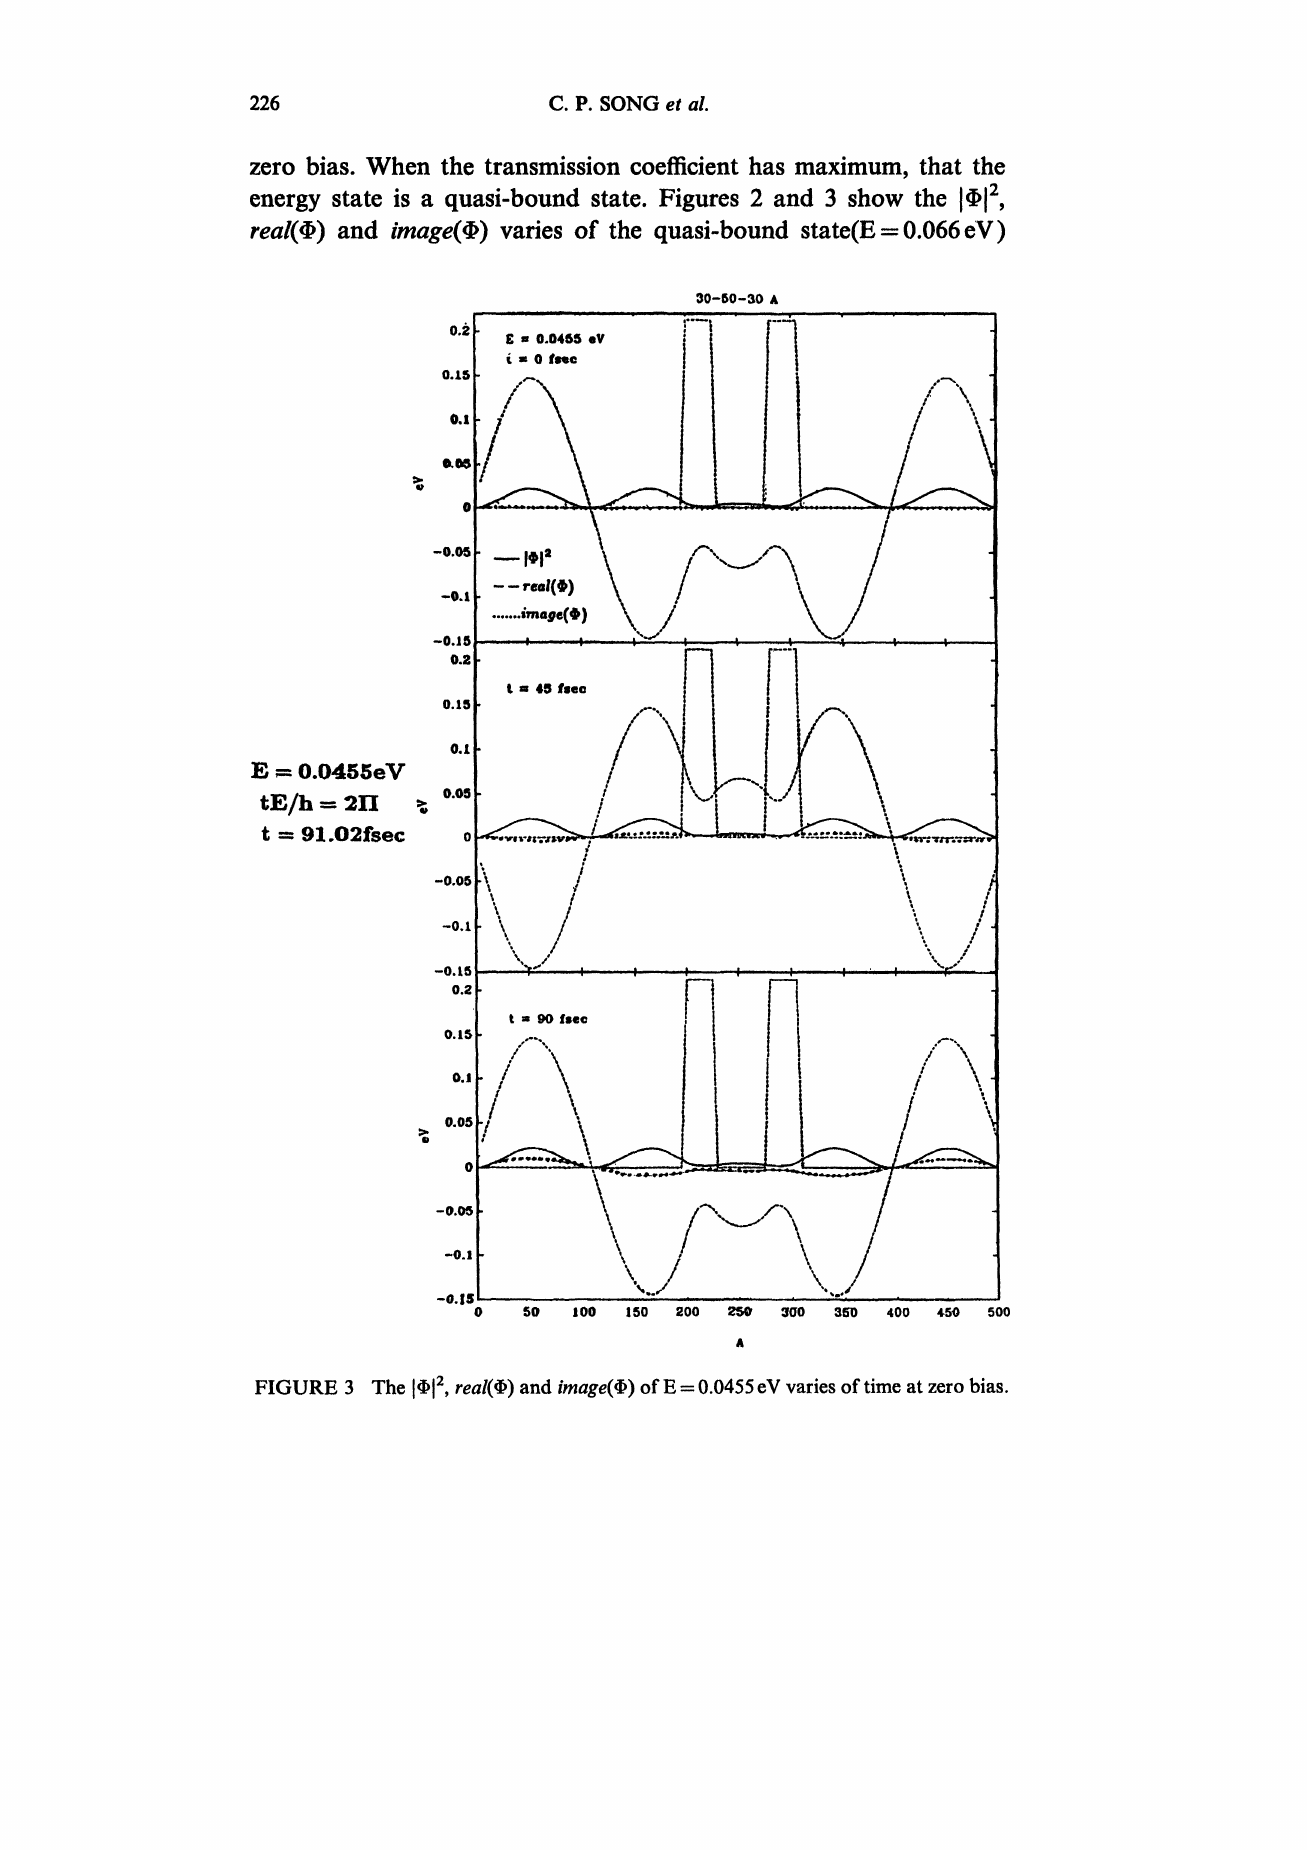
FIGURE 3 The IJ 2, real() and image() ofE 0.0455eV varies of time at zero